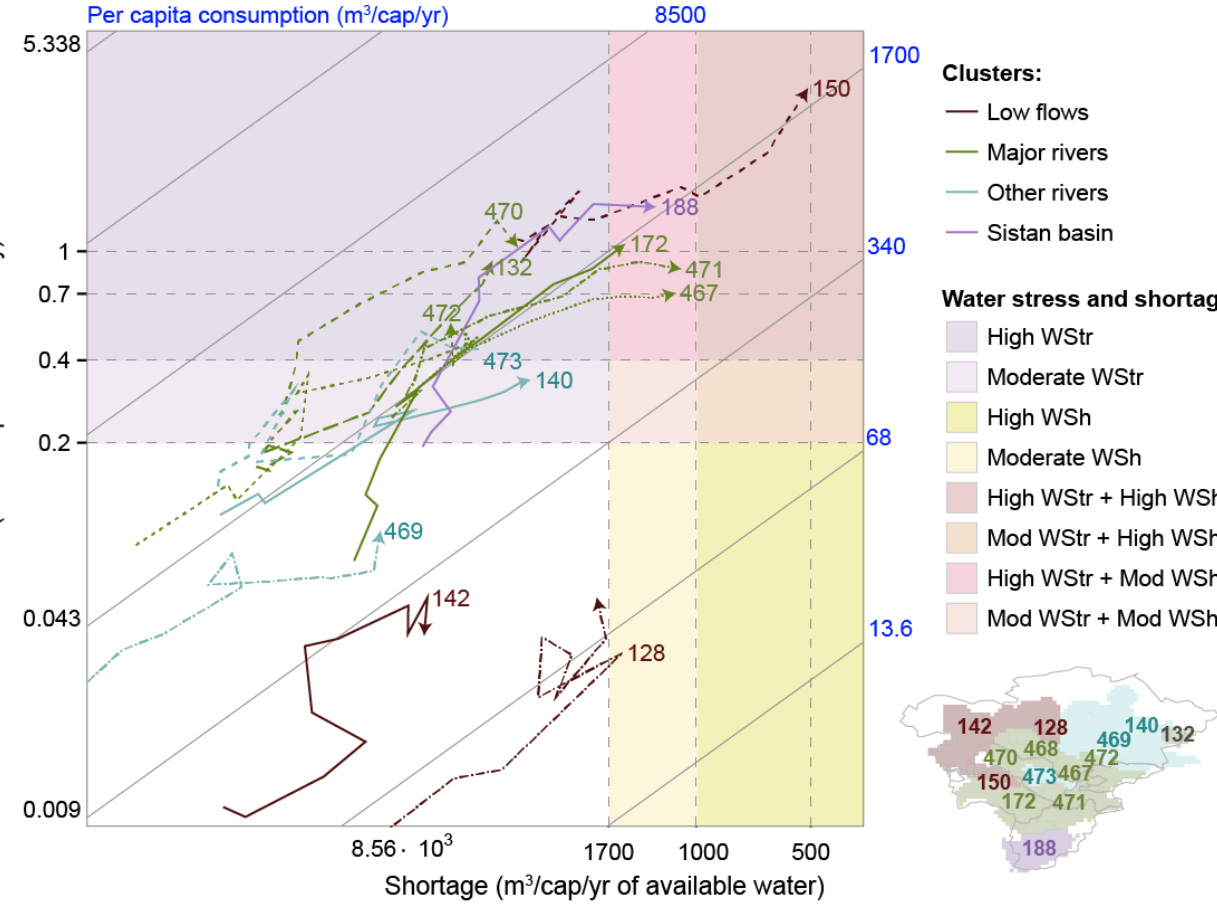
Figure 6. Water scarcity trajectories of each FPU for the 20th century, showing change in shortage, stress, and per capita consumption over time. The diagonal lines refer to per capita consumption isolines. Background colors show existence of moderate and high water stress (consumption respectively >20% and >40% of available water) and moderate and high water shortage (<1700 m 3 /cap/year and <1000 m 3 /cap/year), as used in Porkka et al. [26]. Water shortage is measured by the per capita availability of water. It is also referred to as water crowding, in which case it is interpreted as an indicator of competition for water [48]. A water shortage of 500 m 3 per capita per year corresponds to 2000 people sharing one gigaliter of water per year [47]. A point in the trajectories in Figure 6 represents the average stress and shortage of an FPU for a particular decade, calculated using the data presented in previous sections. Consistent with the preceding results, the overall shape of the trajectories from the bottom-left to the top-right indicates an increase in both stress and shortage over time as human water use and population increases. Per capita consumption is shown with a diagonal grid. The change in position of the trajectories relative to the diagonal grid shows an increase and, in some cases, later decrease consistent with the expansion of irrigation and the dissolution of the Soviet Union. Boundaries indicating multiple levels of water stress and shortage are shown using dashed lines and shading in the background. The trajectories for all